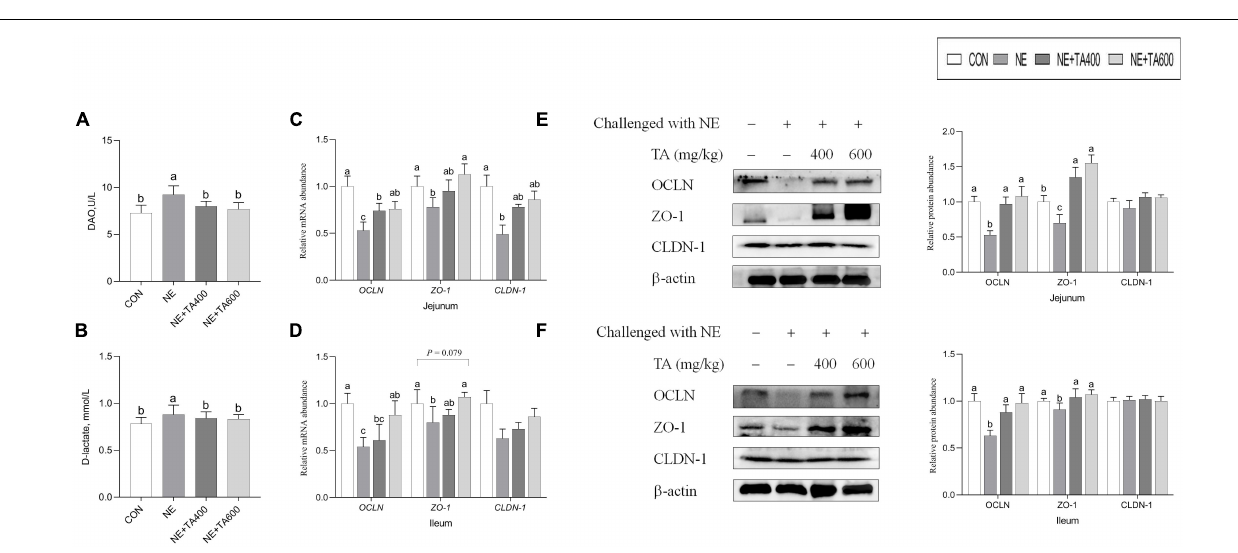
FIGURE 2 | The effects of TA on the intestinal barrier function of subclinical NE broilers. (A) Serum DAO activity; (B) serum D-lactate concentration; (C,D) the mRNA abundance of jejunal and ileal OCLN , ZO-1 , and CLDN-1 ; (E) the protein levels of jejunal OCLN, ZO-1, and CLDN-1; (F) the protein levels of ileal OCLN, ZO-1, and CLDN-1. Values were presented as mean with standard error represented by vertical bars. a , b Means with different letters differ significantly among the groups ( P < 0.05). OCLN, occludin; ZO-1, zonula occludens-1; CLDN-1,